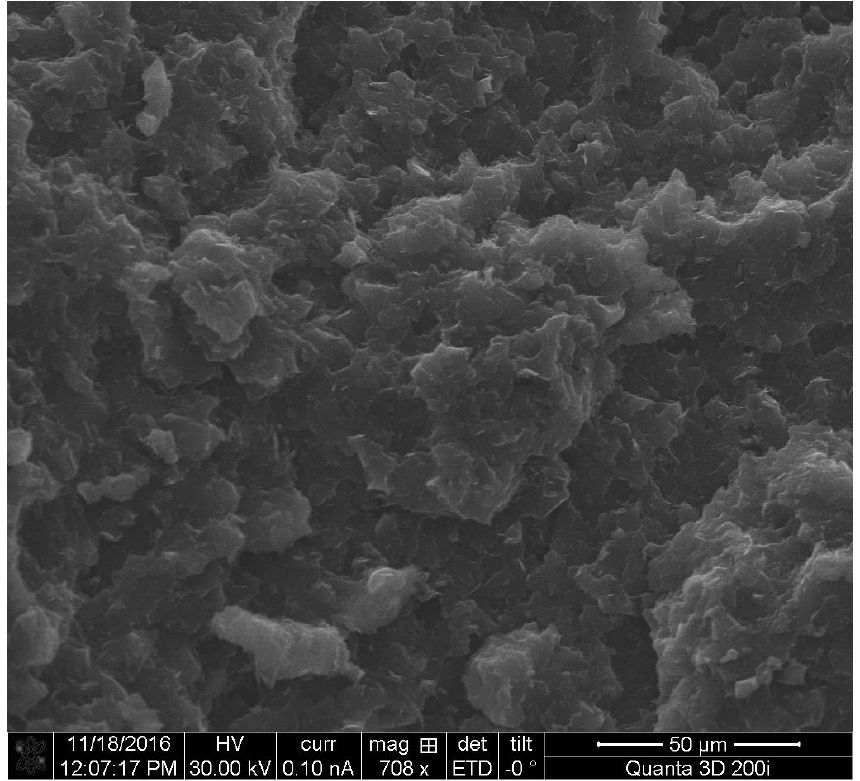
Figure 1. SEM micrograph of cross-section filament–virgin PETG composite containing 5 wt.% of the expanded graphite.